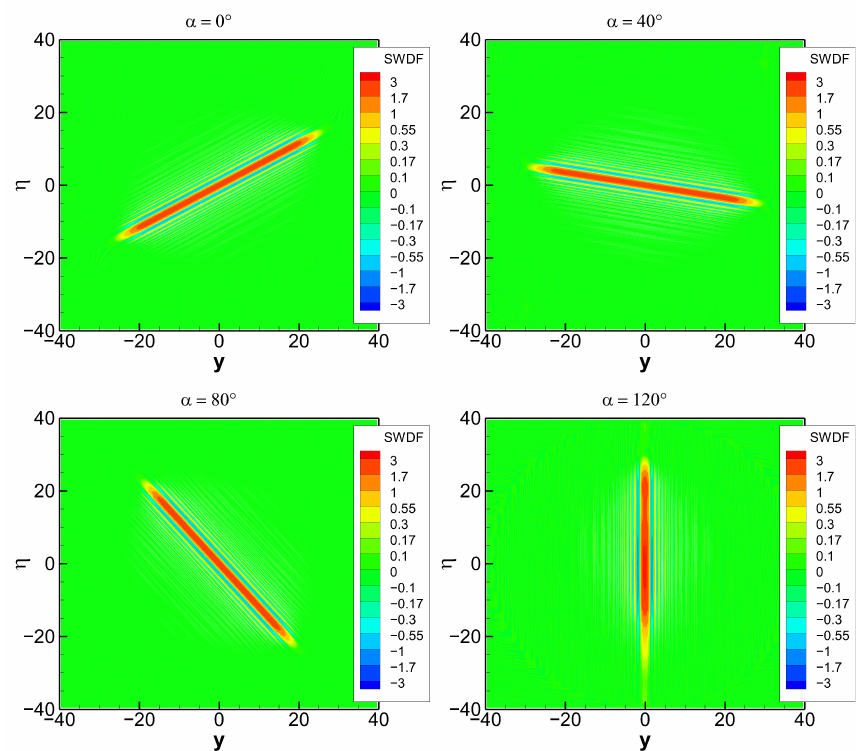
Figure 5. SWDF ρ WK α of function ˜ ψ α ( y ) in rotated coordinates ( y , η ) . The rotation angle α takes the values of 0 ◦ , 40 ◦ , 80 ◦ , and 120 ◦